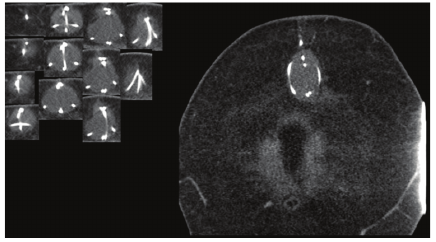
Figure 1: CT images from first VP shunt extrusion. Figure 2: Second episode of VP shunt migration into the abdominal